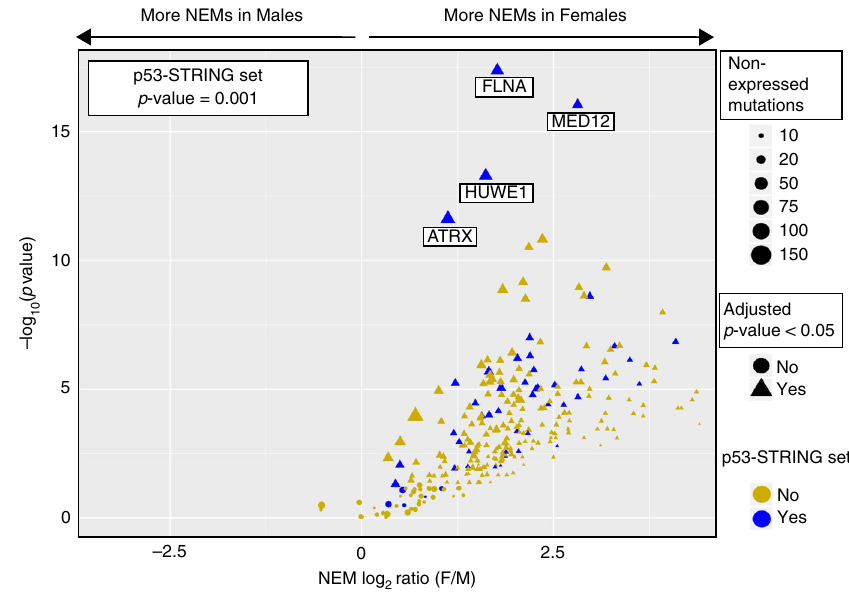
Fig. 4 Non-expressed mutation (NEM) frequencies were signi fi cant only in females, and the p53-STRING set genes were more prominent than the other X- chromosome genes. The relative incidence ( x -axis: log 2 ratio [F/M]) and signi fi cance [ y -axis; - log 10 (p-value)] of NEMs was compared for all X-linked genes between females and males of the 12 disparity cancers. P53-STRING set genes are blue, others are gold. NEMs showing a signi fi cant sex difference are indicated by a triangle, and those lacking signi fi cance by a circle. The number of NEMs for each gene are indicated by a correlative, sliding scale of